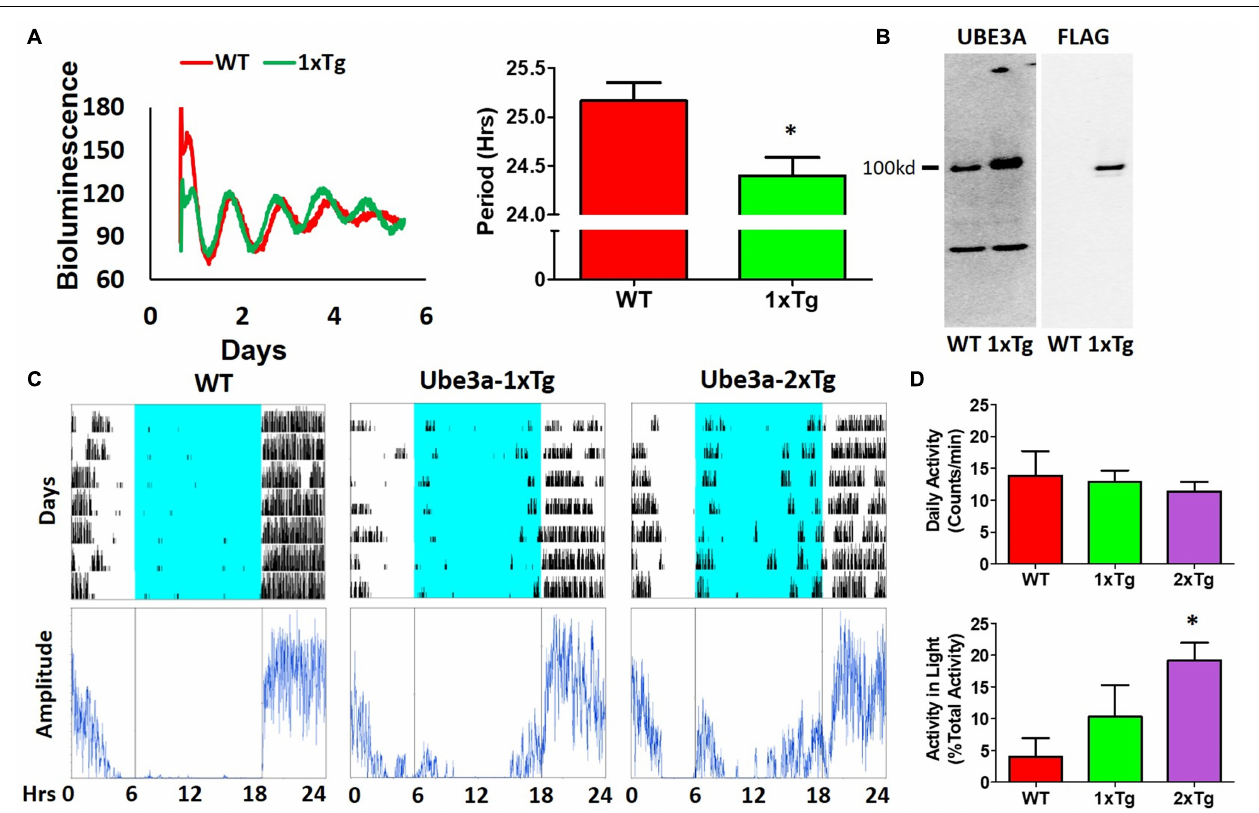
FIGURE 6 | Additional expression of Ube3a shortens molecular rhythms in SCN slices in vitro and increases light-phase activity in vivo. (A) Extra dosage of the Ube3a gene (as the Ube3a -FLAG BAC transgene, aka 1xTg) alters molecular rhythms in explanted suprachiasmatic nuclei (SCN) slices, as assessed with a luminescence reporter of mPER2 expression. SCN slices were collected from P mPer2 ::mPER2-LUC knockin mice in the WT and 1xTg backgrounds. Tissue explants were dissected on Day 0, recorded with a LumiCycle apparatus, and luminescence traces are shown in the left panel. Red: WT; Green: Ube3a 1x transgene. Histograms: period analysis of the SCN data plotted as mean ± SEM (WT: n = 3, 1xTg: n = 4), * p < 0.05 by two-tail unpaired T test. (B) Immunoblots of UBE3A and FLAG tag in the SCN of WT and 1xTg mice. The line labeled “100kd” indicates the specific bands of UBE3A-FLAG identified by anti-UBE3A and anti-FLAG antibodies, respectively. (C) Representative data for mice in LD depict the wheel-running activity (upper panels) of WT (no additional Ube3a dosage), 1xTg (one copy of transgenic Ube3a -FLAG), and 2xTg (two copies of transgenic Ube3a -FLAG) with accompanying amplitude analyses (lower panel) computed by ClockLab. (D) Wheel-running activity analyses for total daily activity (upper panel) and activity in the light phase (lower panel) were computed by ClockLab software for the data under the protocol of (C) . Data are plotted as mean ± SEM (WT: n = 3, 1xTg: n = 4, 2xTg: n = 3), ∗ p < 0.05 between WT and 2xTg by two-tail unpaired T